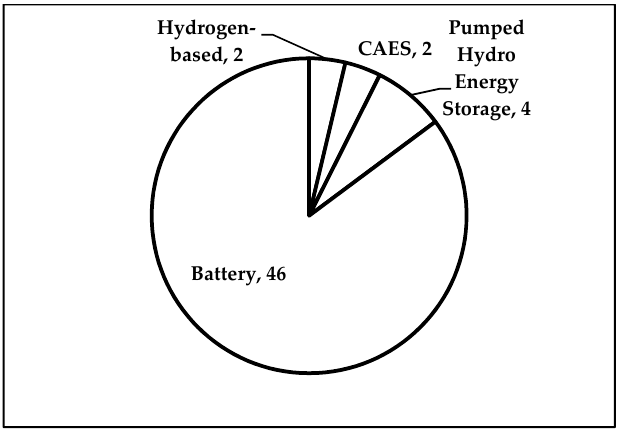
Figure 7. Distribution of empirical articles by ESS technologies.